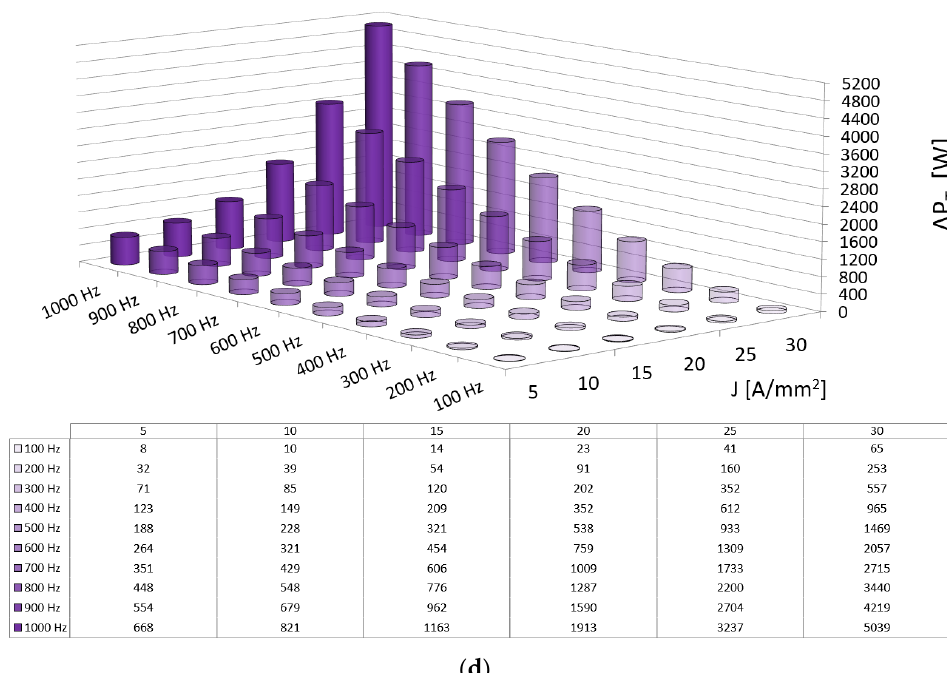
Figure 6. The value of total rotor losses Δ P Tr ( a ) SMC rotor; ( b ) M400 rotor; ( c ) NO27 rotor; ( d ) Va- coflux rotor.